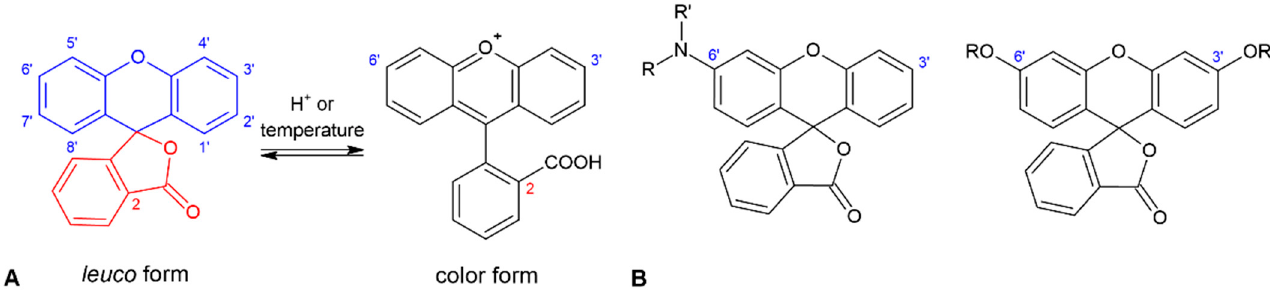
Figure 1. Leuco and color form of fluoran ( A ) and examples of typical substitution of fluoran-based leuco-dyes ( B ).